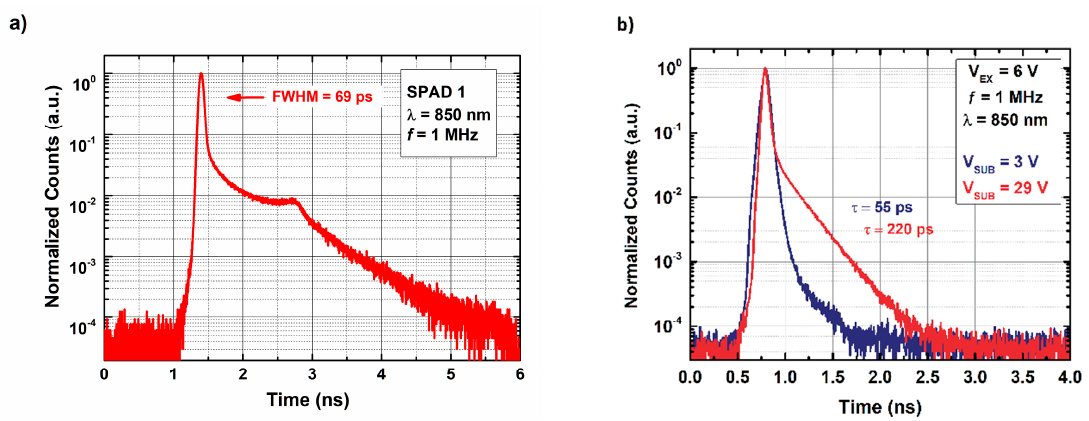
Figure 9. ( a , b ) SPAD 1 temporal response to a 55 ps (FWHM) laser pulse at 850 nm. SPADs are operated with 6 V excess bias voltage with 50 ns gate at 1 MHz. Each curve is normalized to its main peak. ( a ) All the 16 SPADs are enabled, with optical crosstalk component clearly visible after the main peak. ( b ) The same gate signal is applied only to odd SPADs and a comparison between di ff erent di ff usion-tail time-constants at di ff erent substrate voltages is reported: a voltage close to anode one gives lower time constant (blue curve); a voltage close to cathode one gives enhanced Single-Photon Timing Resolution (SPTR) (red curve). Table 1. Optical performance of the 16 × 1 fast-gated SPAD array when operated with 5 V excess bias.